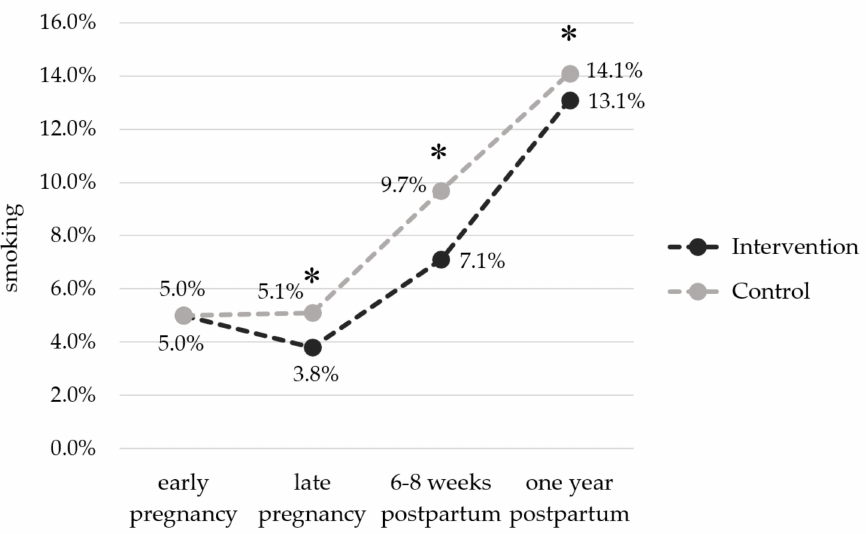
Figure 2. Percentage of smokers in the intervention and control groups from pregnancy to one year postpartum. Early pregnancy: IG: n = 47/931, CG: n = 46/922; late pregnancy: IG: n = 35/916, CG: n = 46/906; 6–8 weeks postpartum: IG: n = 64/905, CG: n = 88/910; one year postpartum: IG: n = 103/785, CG: n = 109/772. * p <